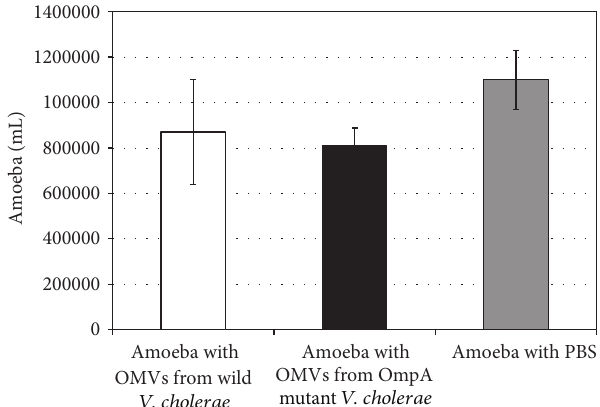
Figure6:Effectofoutermembranevesicles(OMVs)fromwild-type and OmpA mutant strains of V. cholerae on viability of A. castellanii . Data represent mean ± SD from three different